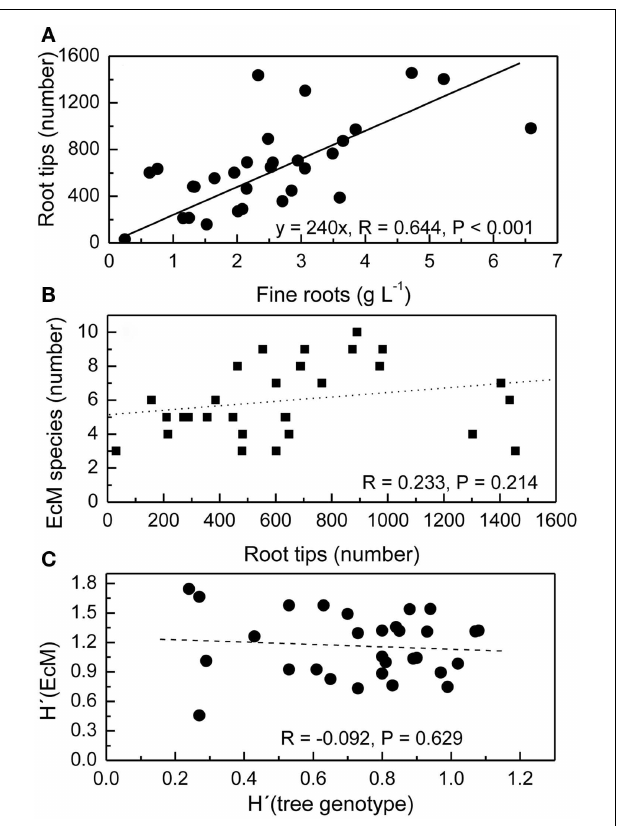
FIGURE 2 | Relationships between the number of root tips and fine root mass per soil core (A), the number of ectomycorrhizal fungal species (EcM) and the number of root tips per soil core (B), and the Shannon–Wiener index H (cid:48) of EcM diversity and root genotype diversity H (cid:48) (tree genotype) per soil core (C). The volume of the soil core was 1L. All root tips were counted and